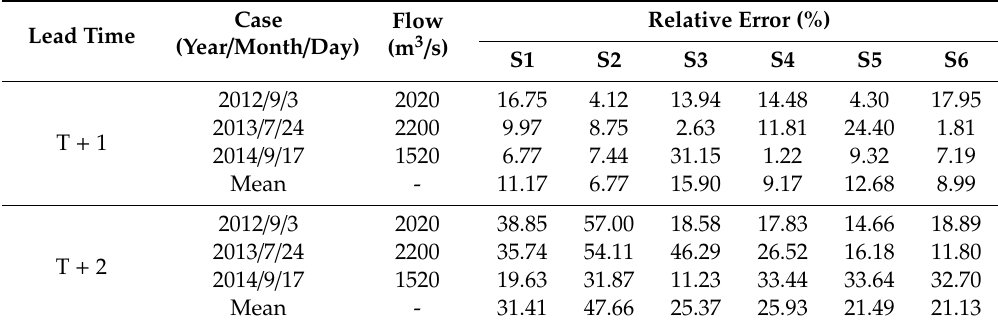
Table 7. The relative error of the simulated flood peaks in each scenario for T + 1 and T + 2 forecasting. Case Relative Error (%) Flow Lead Time (Year / Month / Day) (m 3 / s) S1 S2 S3 S4 S5 S6 2012 / 9 / T + 1